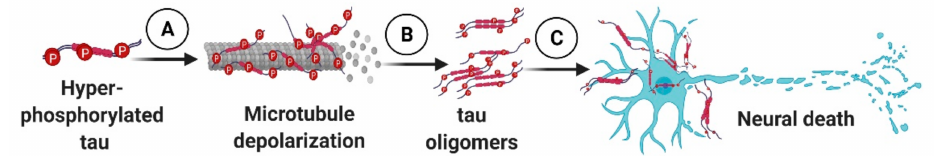
Figure 1. Hyperphosphorylated tau. ( A ) Hyperphosphorylation of tau protein causes microtubule depolarization. ( B ) Tau oligomer aggregation and formation, which assembled to manufacture of neurofibrillary tangles. ( C ) Neural death and release of tau oligomers to the extra-cellular